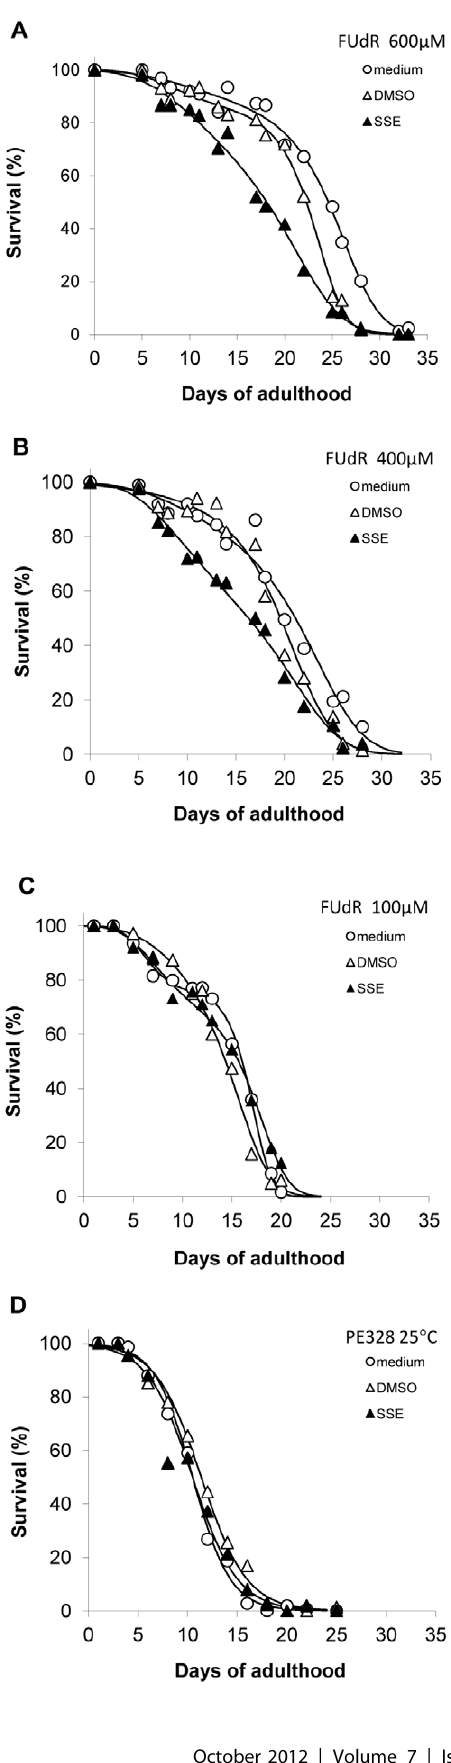
Figure 5. L1 SSE exposure did not affect egg laying rate or in utero egg number. (A) Worms grown on NGM plates in the presence or absence of DMSO 1% or SSE 1% were transferred singly to 8 different plates (n=8): the numbers of eggs laid were determined for the first hour after transfer and then for the second hour and averaged. (B) Adult worms (n=11) from plates or (C) (n=23) from liquid culture, grown in the presence or absence of DMSO or SSE, were transferred singly to 10 m l bleach on a microscope slide; after a few minutes the adults dissolved and eggs were counted [43]. (A) represents data from 1 of 2 independent experiments and (B) and (C) represent pooled data from 2 and 3 independent experiments respectively.